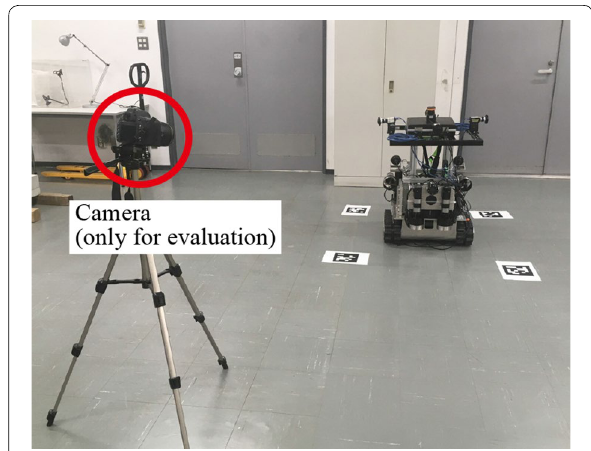
Fig. 10 Example of scenes when images of the robot are taken from outside by using a reference camera (only for